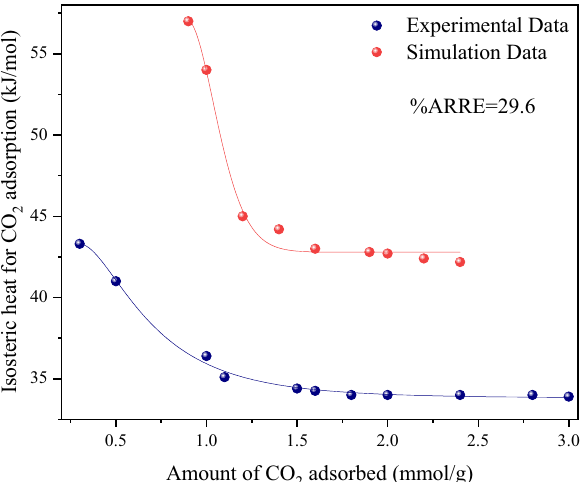
Figure 11. Experimental and simulation CO 2 isosteric heat of adsorption at three different temperatures of 298, 308, and 318